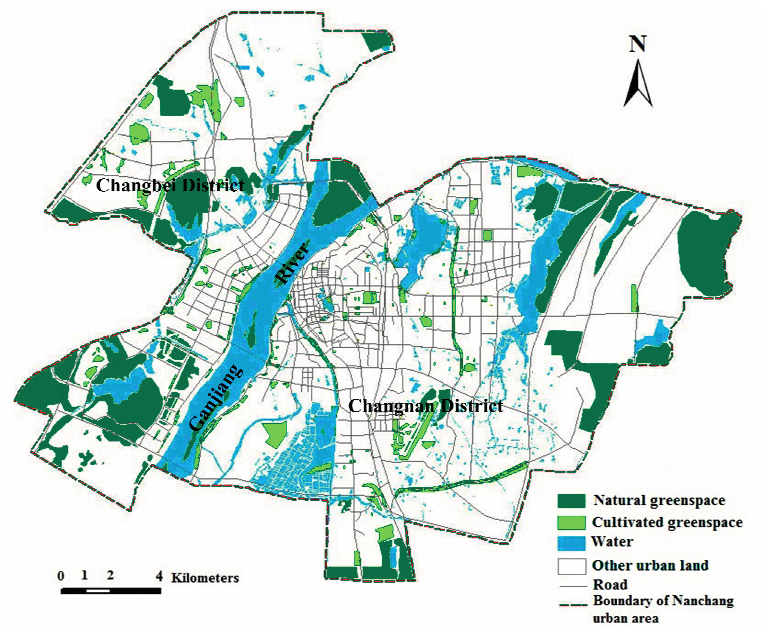
Figure 1. Distribution map of urban green space in 2005.